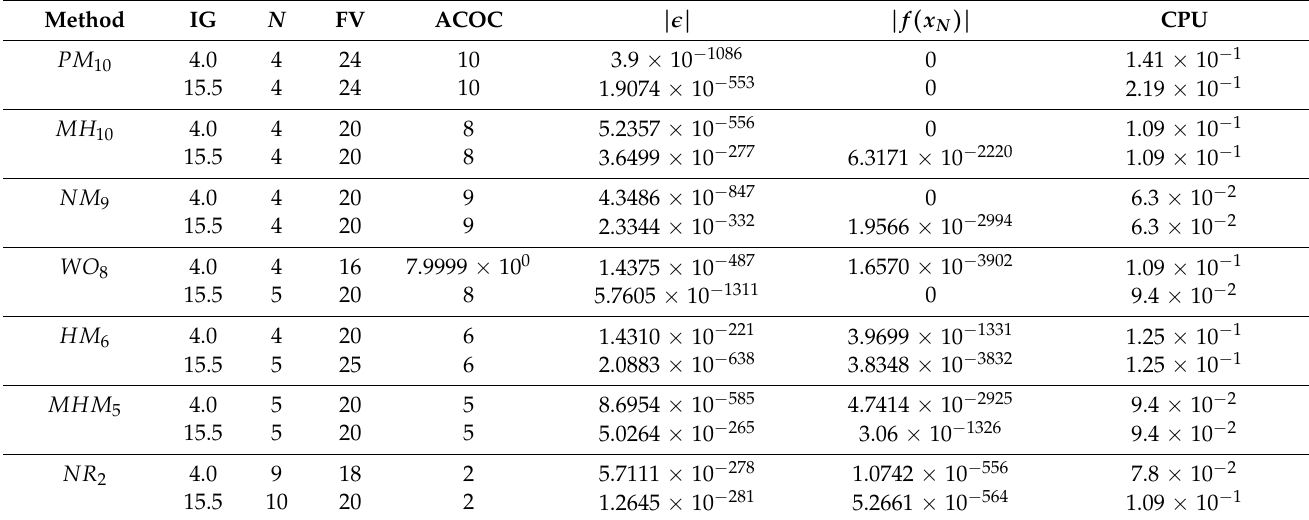
Table 11. Numerical results for problem